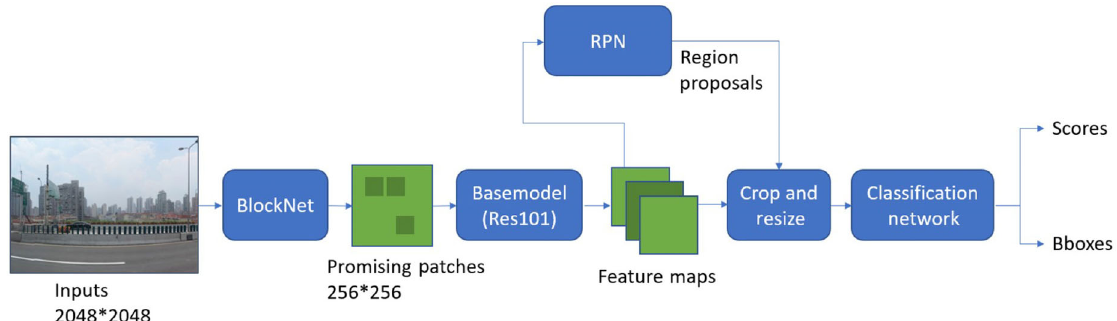
Fig. 1 Pipeline of the proposed architecture. The first stage, BlockNet, divides the input image into 256 overlapping squares and extracts features from each. After pushing these feature maps through a softmax layer, the network determines which blocks potentially include traffic signs, before passing them to later modules. All modules after BlockNet belong to the second stage. Res101 is used to extract fine features. RPN, at the side, covers the feature maps with anchors of various scales and ratios, and finally supplies region proposals back into the trunk. The classification network combines these outputs and performs regression as well as predicting the